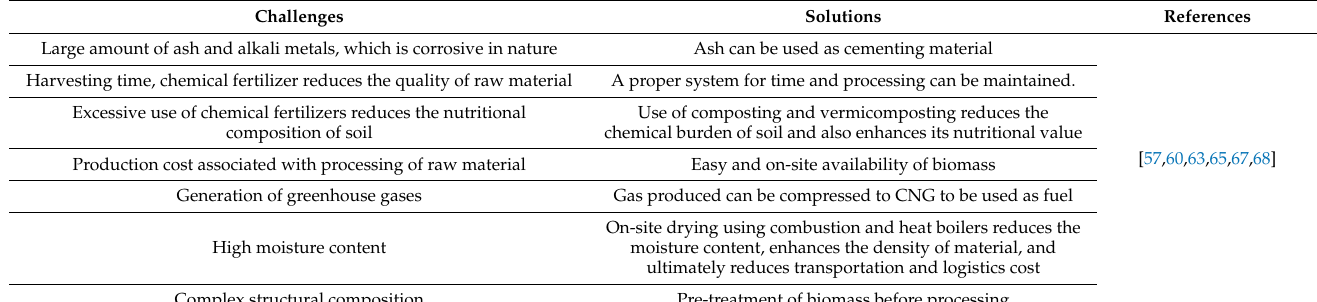
Table 3. Challenges associated with complete utilization of paddy straw for biorefinery and their possible